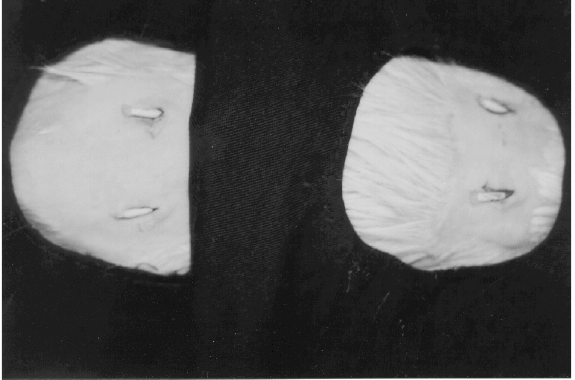
FIGURA 1 - implantação dos tubos de polietileno